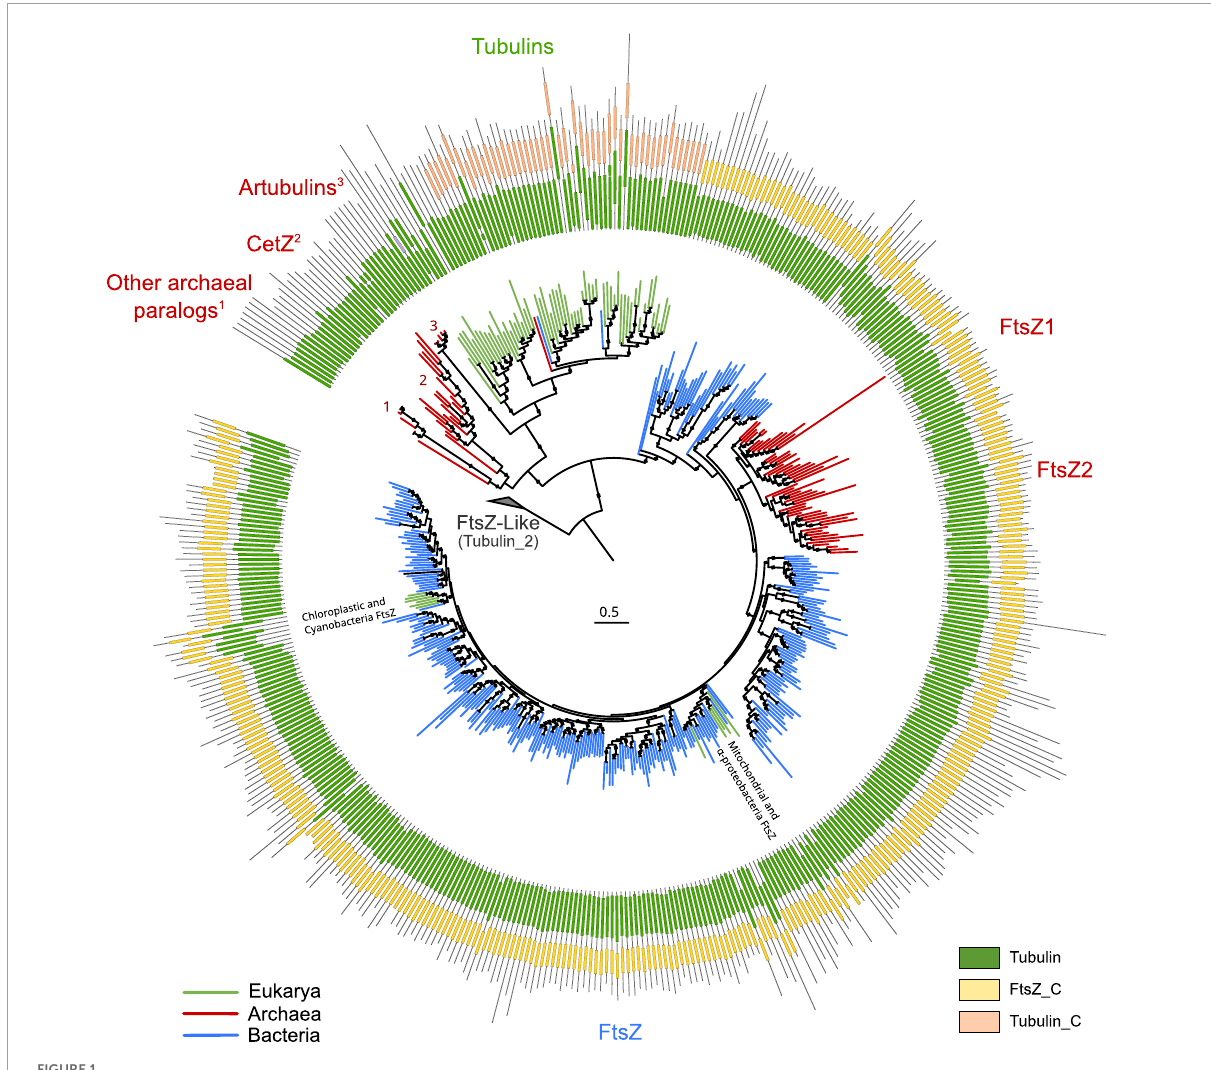
FIGURE1 Overview of the FtsZ/tubulin protein family. Schematic phylogeny of representative sequences showing their Pfam domain architectures. Branches are colored according to the taxonomic domain, and black circles indicate bootstraps higher than 90. The tree was rooted at the divergent FtsZ-like sequences containing the Tubulin_2 Pfam domain. Note that some sequences discussed in this study are not shown in this tree (e.g., TubZ and other archaeal